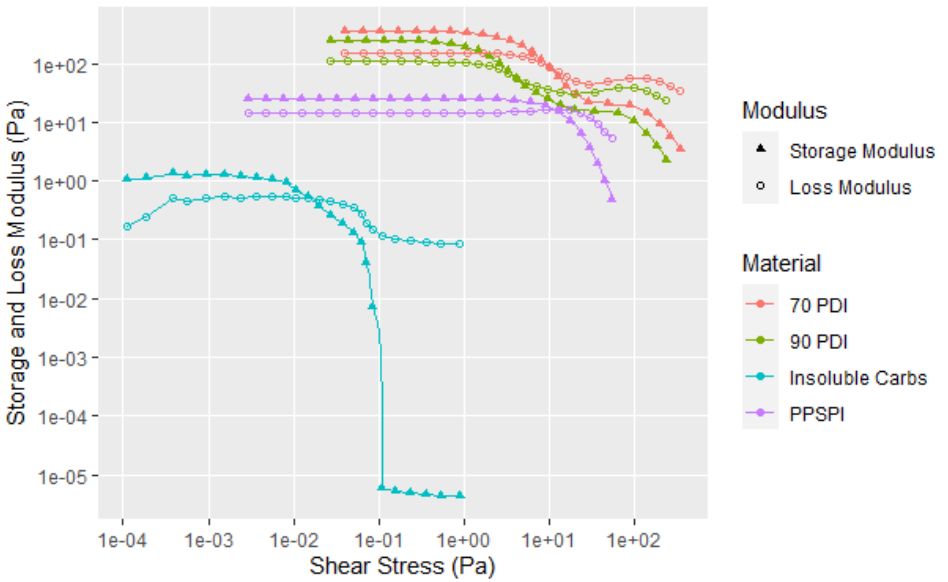
Figure 7. Storage and loss moduli versus applied stress for two soy flours (30 wt. %), native soy protein isolate and soy insoluble fraction (at 15 and 7.5 wt. %, respectively, representing their proportional contribution to the soy flour). Single replicates shown (not average). All replicates shown in A6.